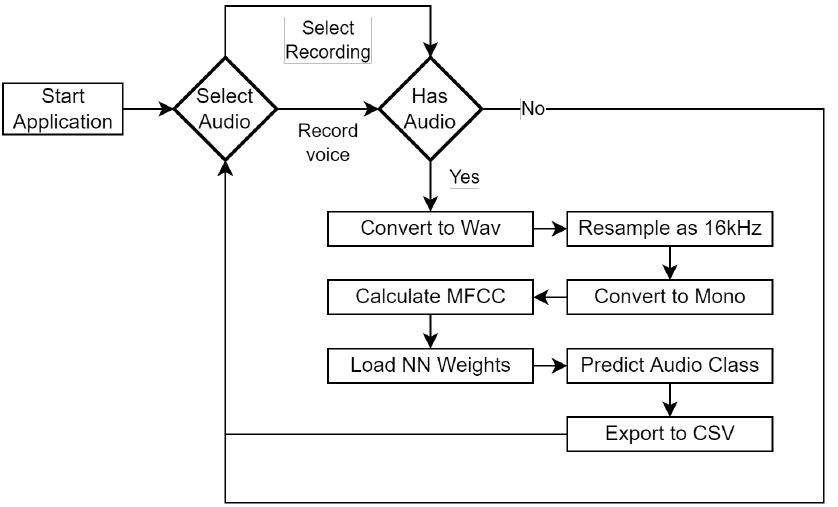
Figure 1. Implementation